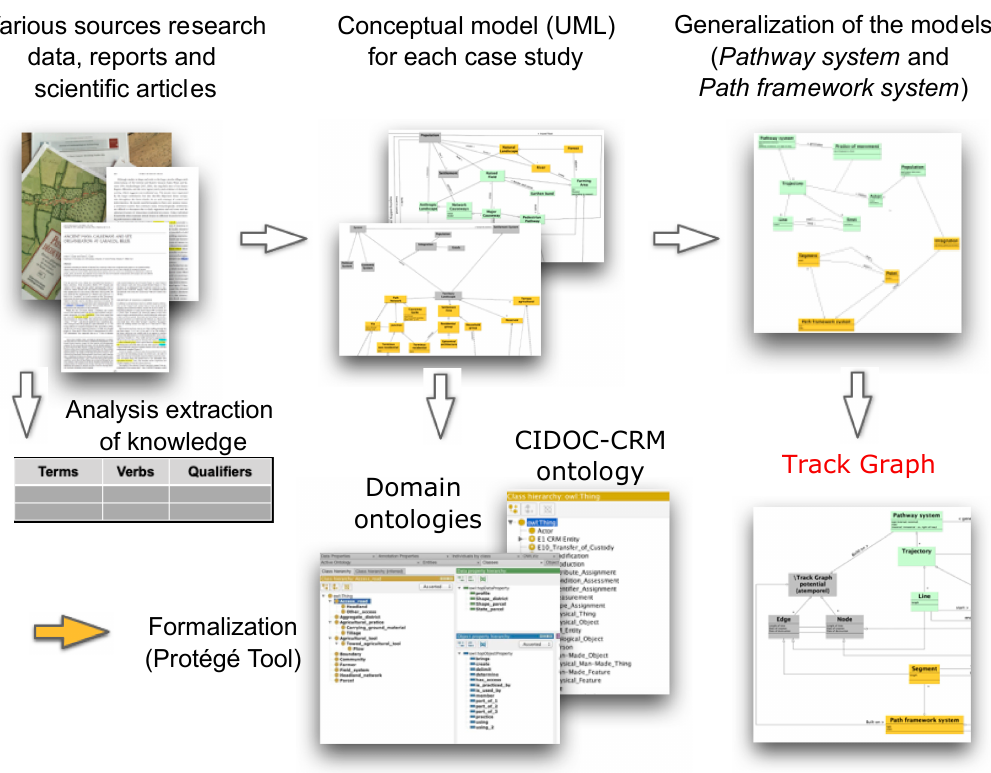
Figure 3. Schema of the approach adopted by our team.